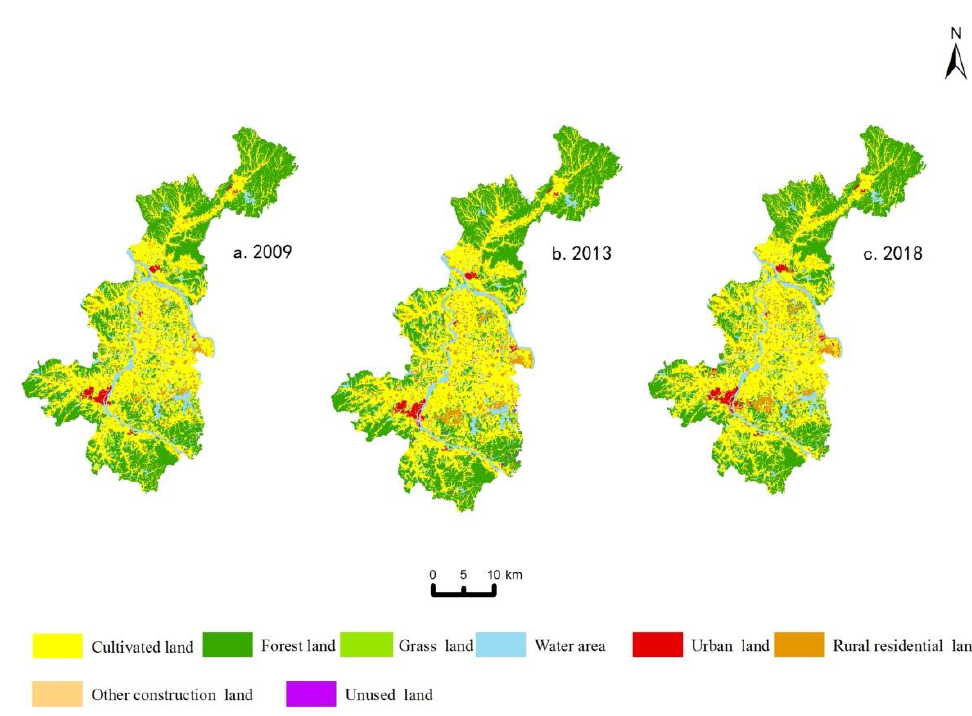
Table 1. Change of land use structure in Yujiang District from 2009 to 2018 .